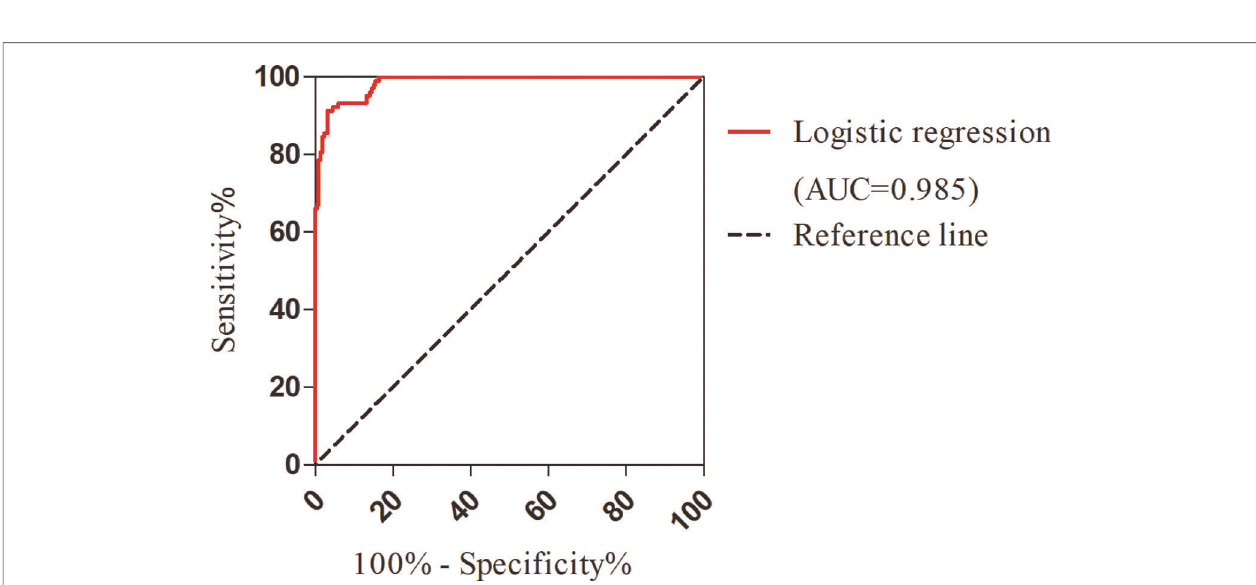
FIGURE 3 | ROC curve for logistic regression models. ROC, receiver operating